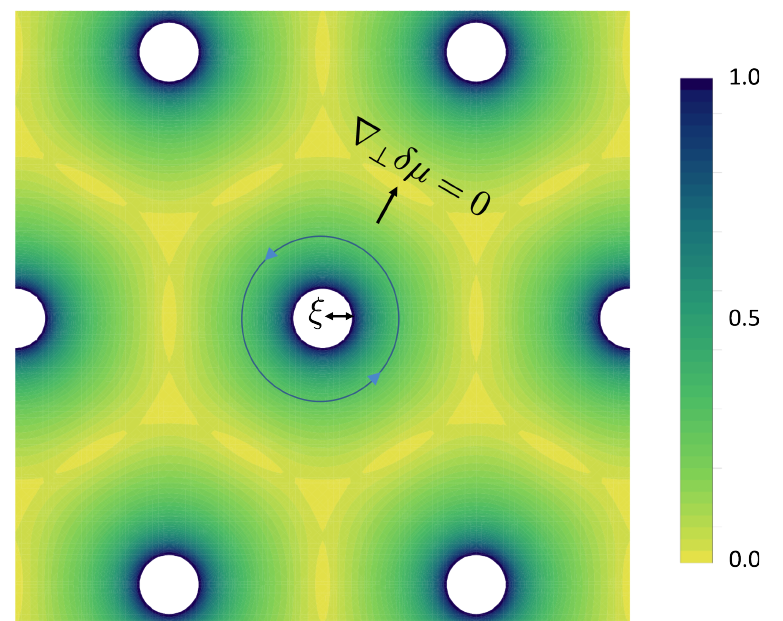
Figure 4: Ginzburg Landau free energy density of a vortex lattice, f vl ( x , y ) of Eq. (22), in arbitrary units. ξ is the vortex core radius, and blue arrows represent a circulating current. The local chemical potential deviation δµ ( x ) = d f vl / dn approximately proportional to f vl ( x , y ) . By symmetry, the normal gradient ∇ ⊥ δµ vanishes on the unit cell boundaries. If the total charge per unit cell is non zero, it must be screened in the third dimension, as depicted in Fig.